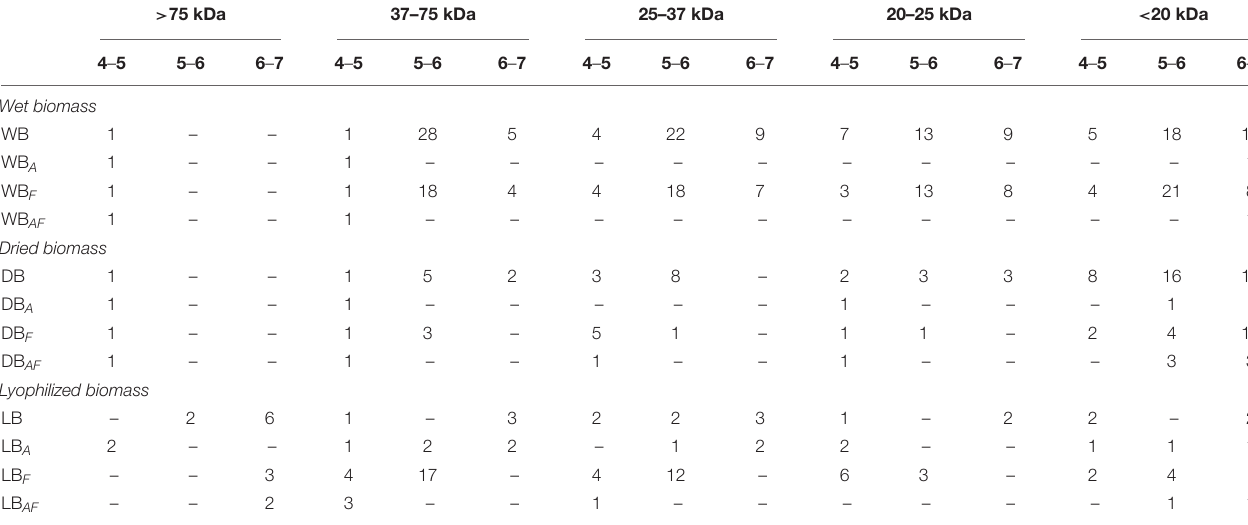
TABLE 2 | Estimated molecular weight range (kilodaltons) of polypeptides found in wet (WB), dried at low temperature (DB), and lyophilized (LB) Spirulina biomass. > 75